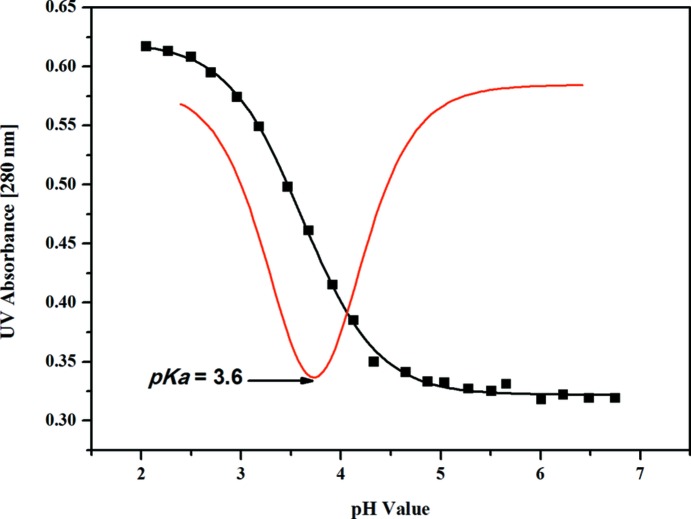
pKa value of 1 determined by UV titration (1st derivative, red line). Spectroscopic changes determined at 280 nm at different pH values (black line) were measured in 0.1 M sodium phosphate buffer.